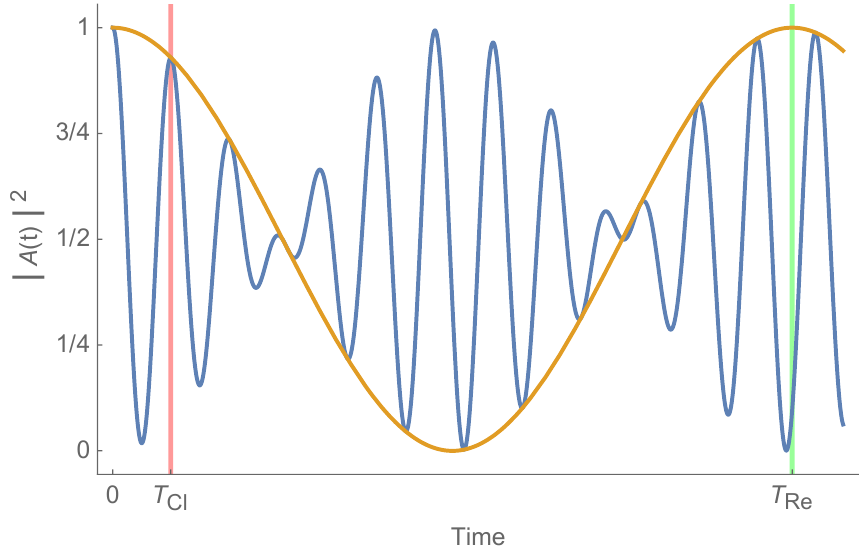
Figure 6. A simple example of the time evolution of the squared modulus of the autocorrelation function in blue with its upper envelope in orange. Classical time is marked in red and revival time in